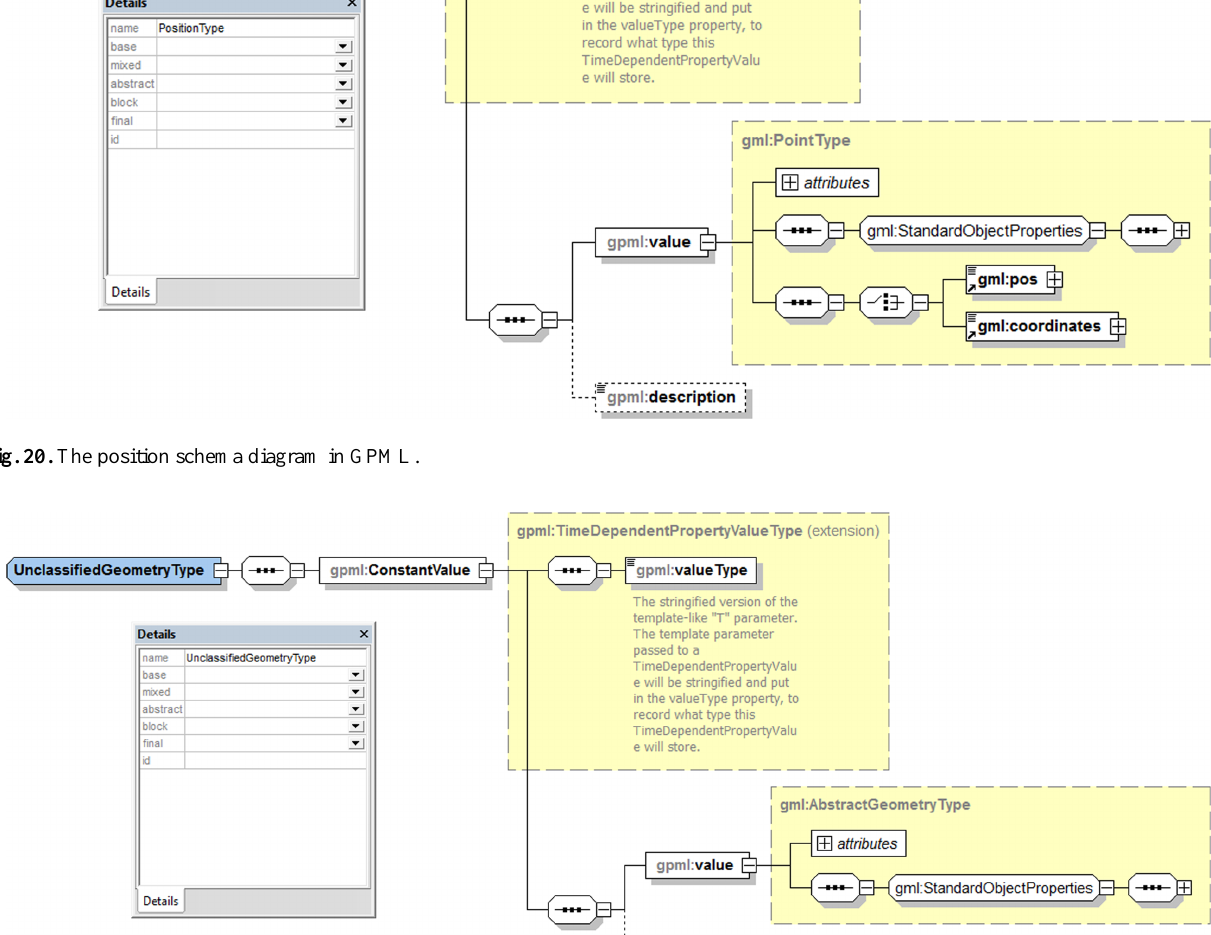
of dynamic typing, although C++ is a static typing language in